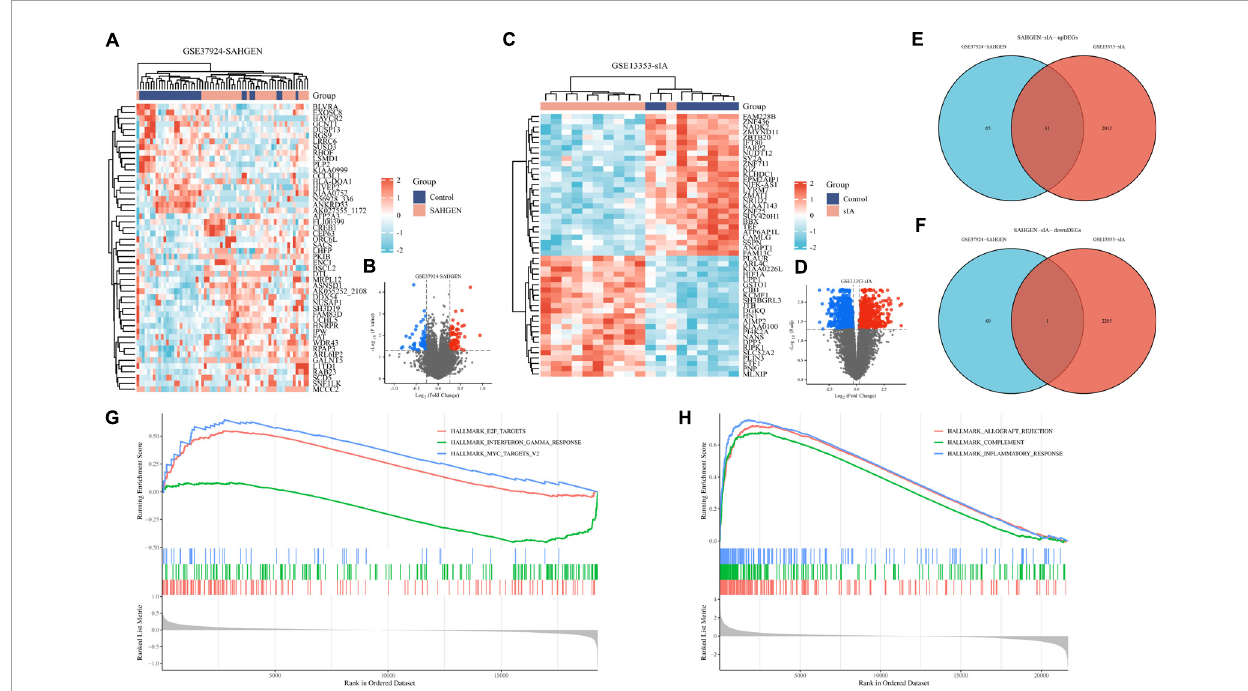
FIGURE1 Transcriptomic analysis of patients with ruptured abdominal aortic aneurysms (AAs) and cerebral vasospasm (CV). (A) Differentially expressed genes associated with AA rupture identified from erythrocyte samples in the GSE37924 dataset. (B) Differentially expressed genes associated with AA rupture identified from erythrocyte samples in the GSE13353 dataset. (C) Differentially expressed genes associated with AA rupture identified from erythrocyte samples in the GSE37824 dataset. (D) Volcano plot of differentially expressed genes in the GSE13353 dataset (red represents upregulated gene expression, while blue represents downregulated gene expression). (E) Venn diagram demonstrating the common upregulated genes in both sample types. (F) Venn diagram demonstrating the common downregulated genes in both sample types. (G) Graph demonstrating the results of gene set enrichment analysis (GSEA) for all samples. (H) Enriched GSEA pathways in all